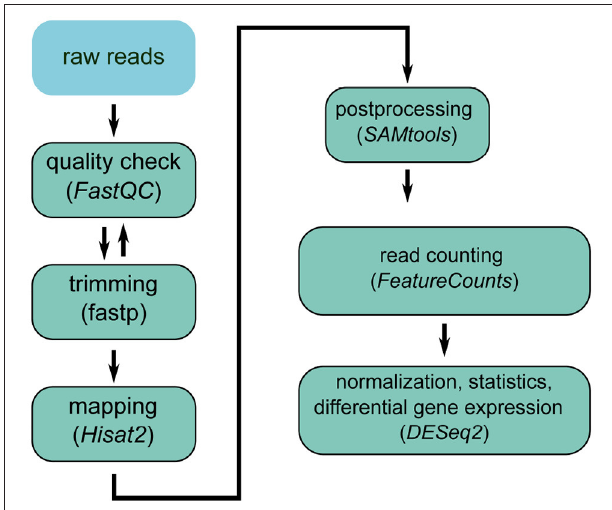
FIGURE 3 | RNA-seq analysis